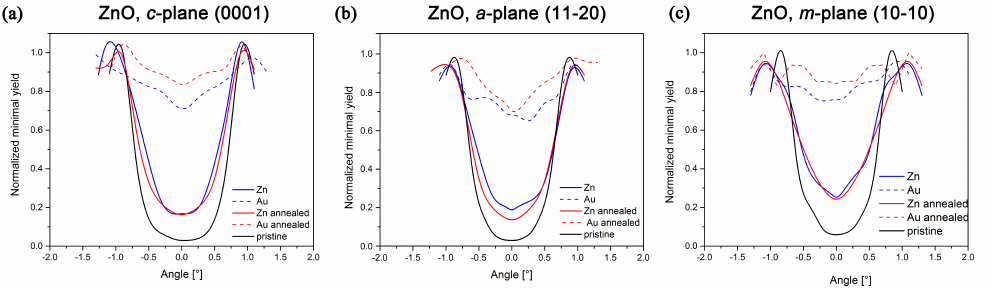
Figure 4. The angular scans provided in the RBS / C analysis of the as-implanted and as-annealed samples: ( a ) c -plane ZnO, ( b ) a -plane ZnO, ( c ) m -plane ZnO. The experimental conditions of the